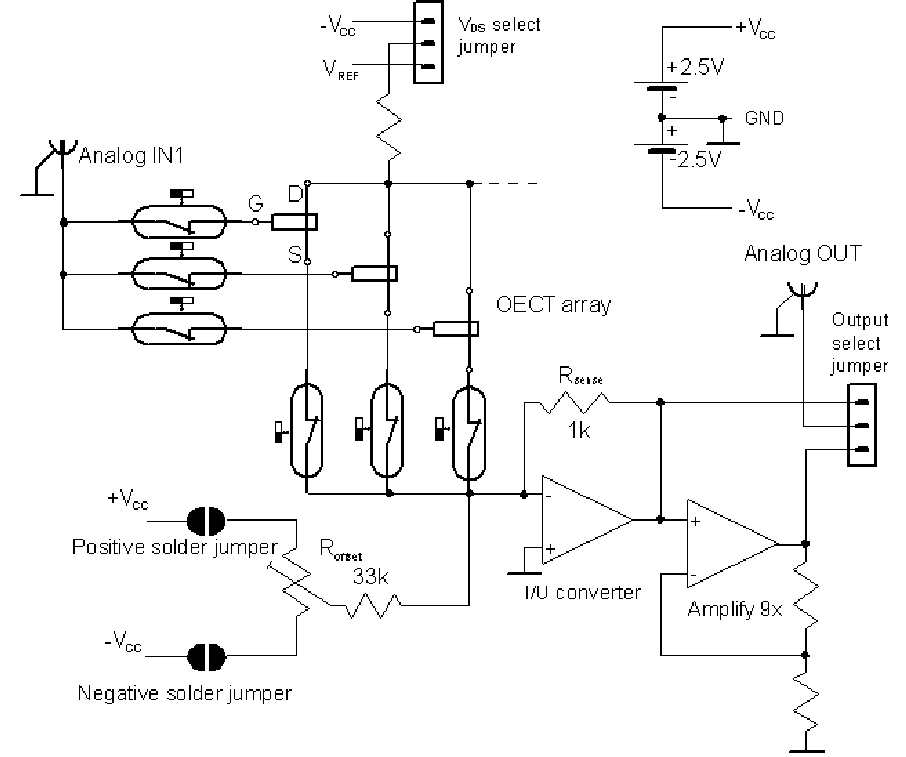
Figure 2. The principle of selecting and testing a single OECT from the 96 OECTs array.